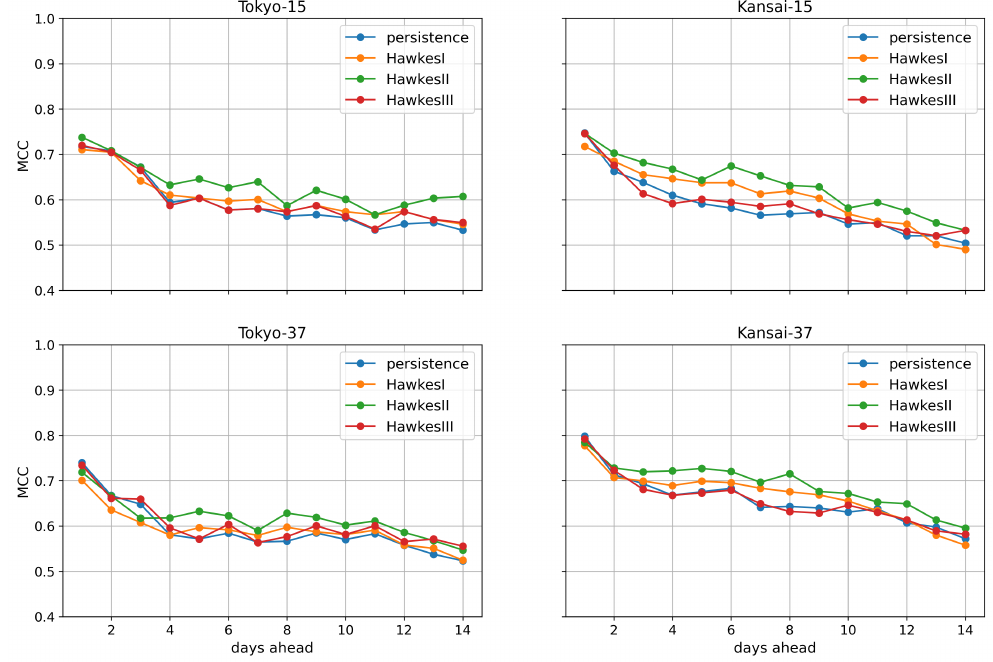
Figure 10. Variation of Matthews correlation coefficients with forecasting horizon for the selected areas and trading time